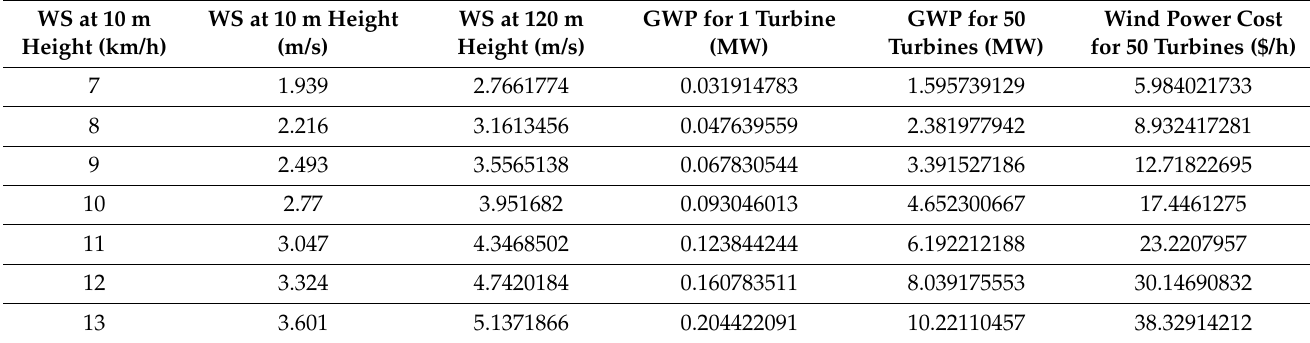
Table 3. Wind Power Quantity and Wind Power Generation